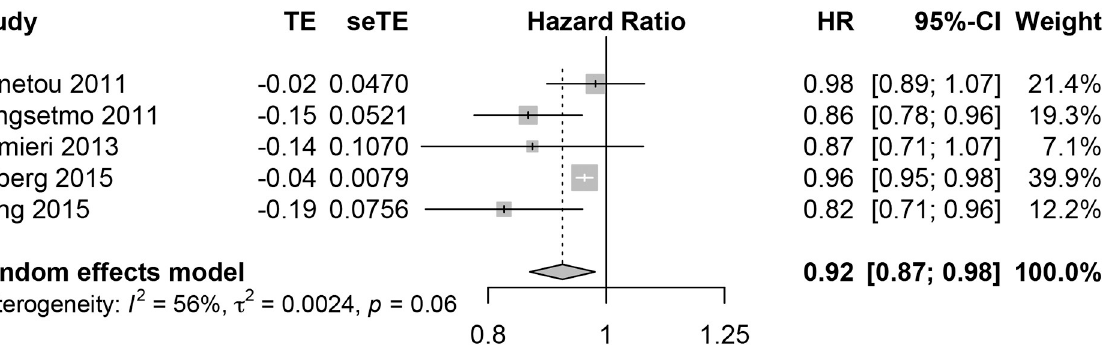
Fig 2. Forest plot of the hazard ratio and 95% confidence interval of the risk of hip fractures with combined fruit and vegetable intake in men and women in cohort